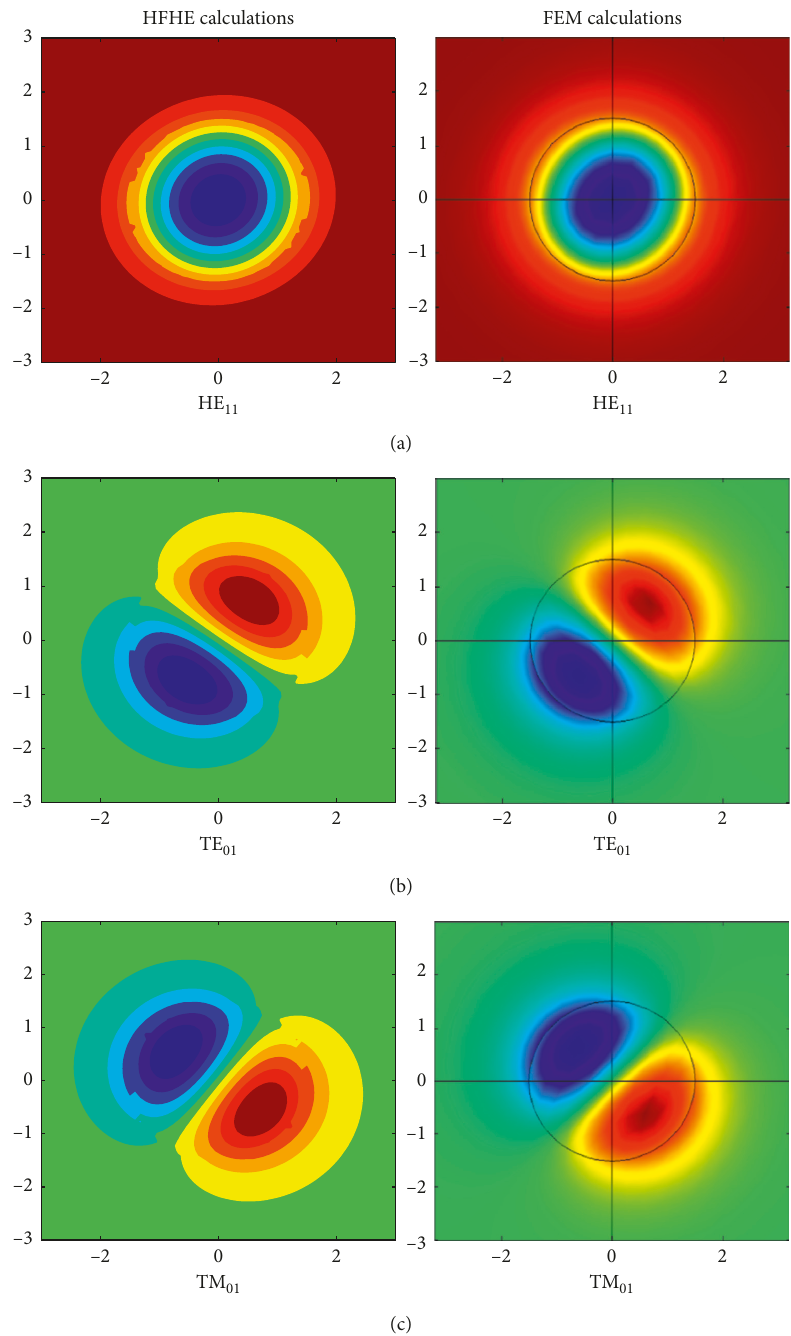
Figure 3: Mode field distributions ( E x component) of the perturbed optical fiber in Figure 1(b). (a) HE 11 , (b) TE 01 , (c) TM 01 . When these field distributions are compared with the unperturbed ones in Figure 1(c), the effect of the perturbation is to rotate the mode distribution in a clockwise